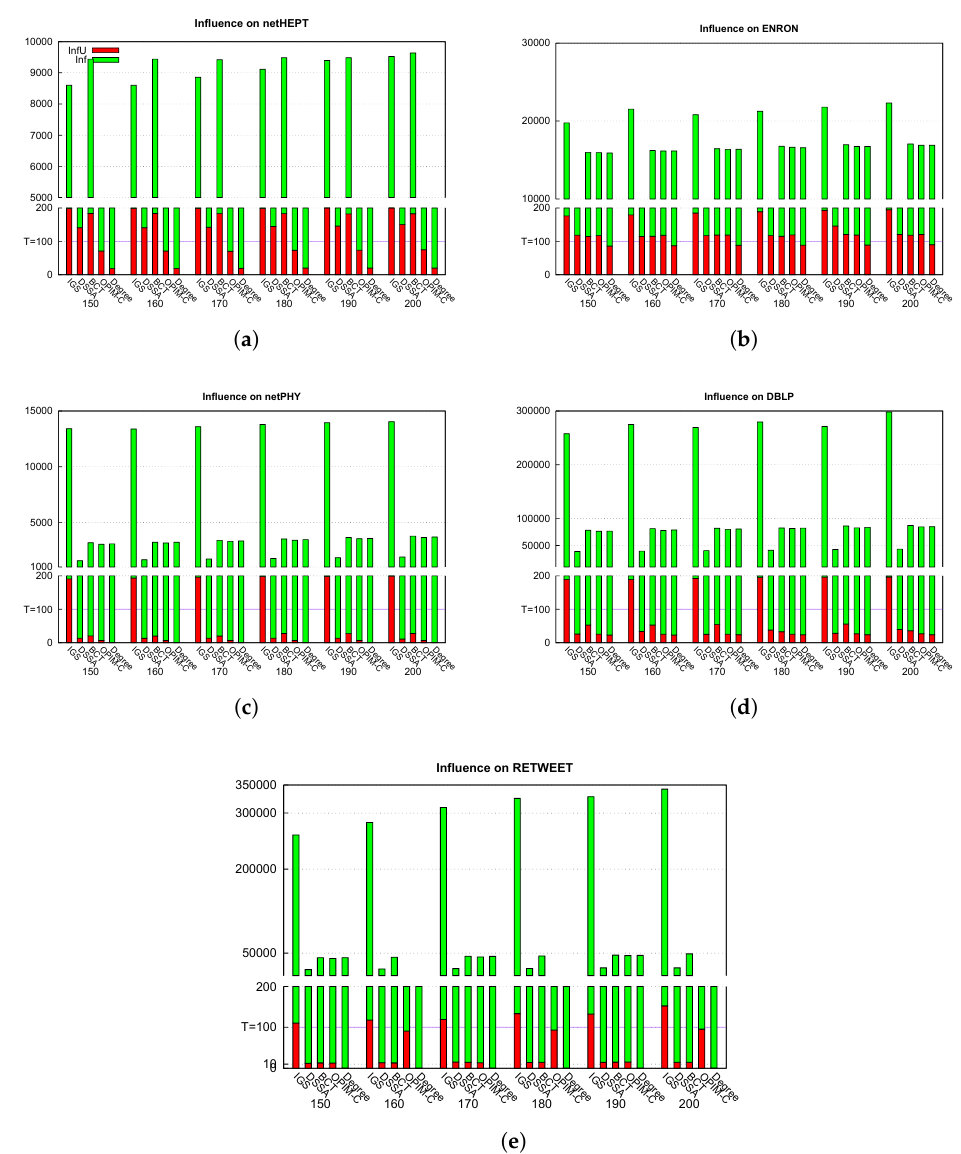
Figure 2. Comparisons of Influence Spreading with k = 100 → 500, T = 100 and U size =